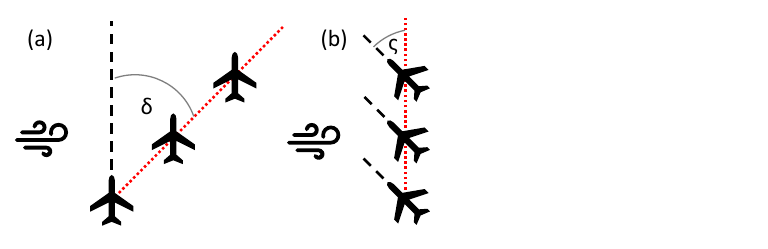
Figure 2. Wind effect to the aircraft. ( a ) Drifting effect of the wind δ -drift angle. ( b ) Compensating the drift by crab flight ς -crab-angle (correction